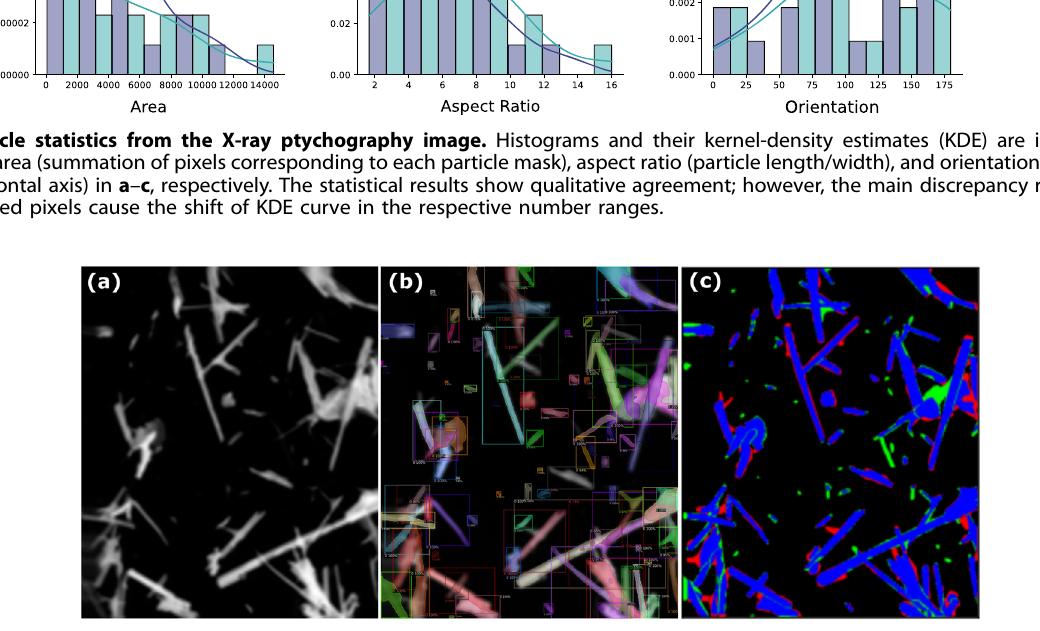
Fig. 6 Model prediction on V 2 O 5 nanowires image by STXM (531 × 449 pixels — rescaled) . a Test image. b Predicted instance masks with lower opacity plotted on the test image. The best performer in AP segmentation mask in Table 3 was used to visualize the prediction masks in b . c Semantic binary mask, Blue: TP, Red: FN, Green: FP; in c , many FP nanowires are present, which indicate the missing manual labels, but detected by the model. The results demonstrate the robustness of the model in segmenting image of low-resolution and densely packed